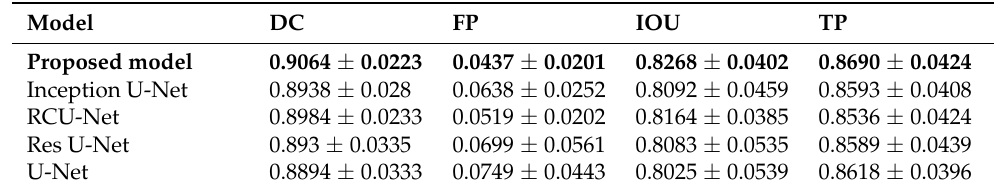
Table 1. The mean and the standard deviation of the four metrics across the 4 outputs and the 5-fold cross-validation. The numbers after the ± represent the standard deviation.